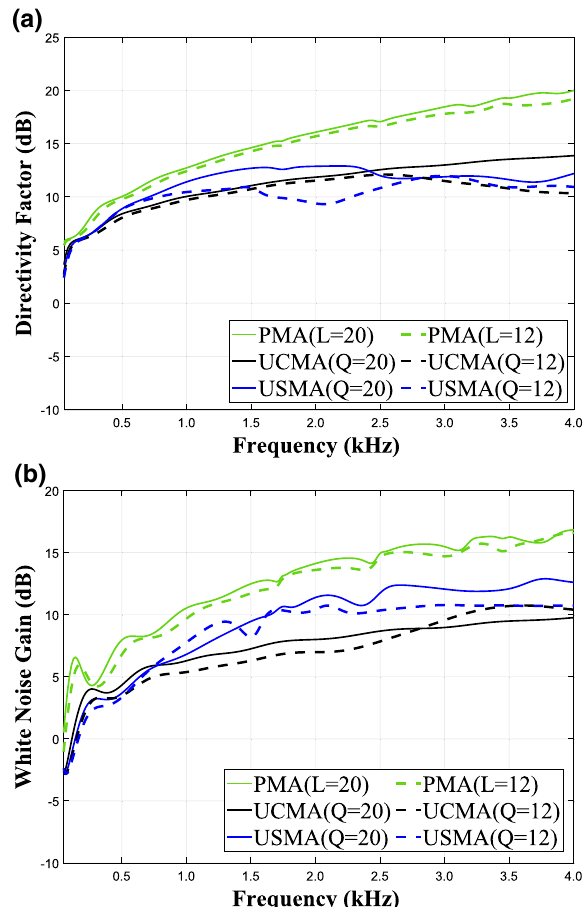
Fig. 7 a The DF and b the WNG of the PMA, the USMA and the UCMA geometries with Q = L = 20 and Q = L =